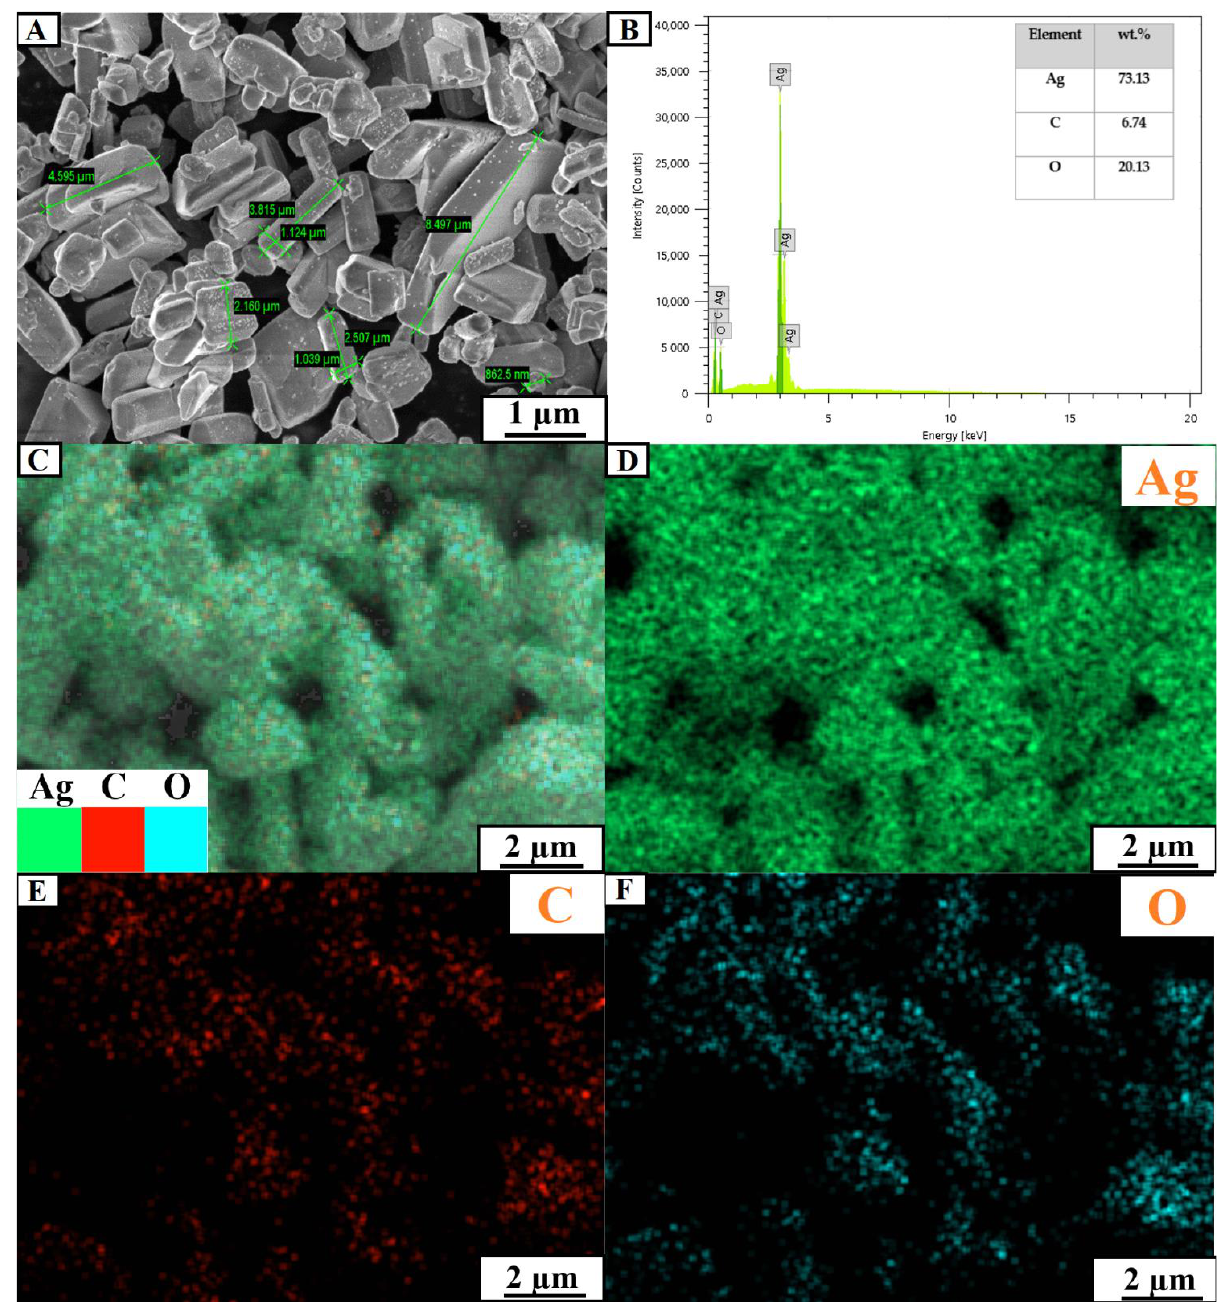
Figure 3. ( A ) SEM image, ( B ) EDS spectrum, and ( C – F ) Elemental mapping of Ag 2 CO 3 .